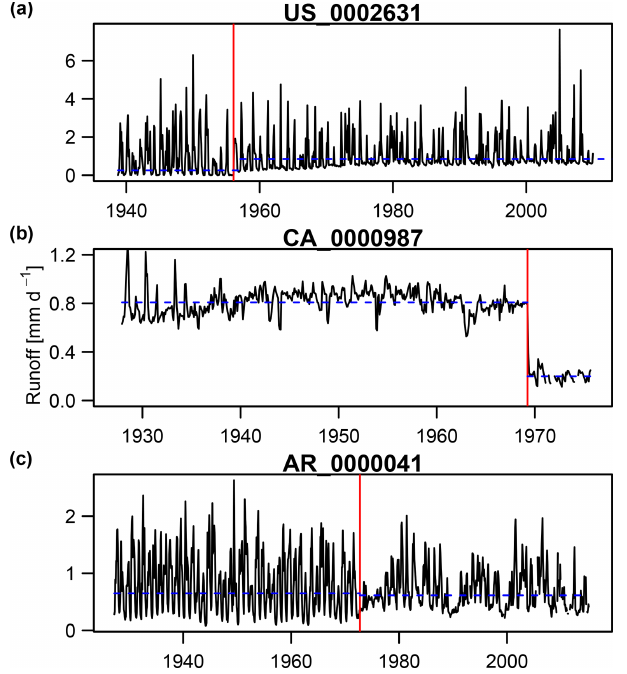
Figure 1. Detection of change points in runoff time series. The ver- tical red line indicates the change point in variance detected by the univariate normal change point in variance test, while the horizontal blue dashed lines illustrate the change in mean identified by the test of univariate normal change point in normal mean and variance. The title of the individual panels corresponds to the station identifier as used in